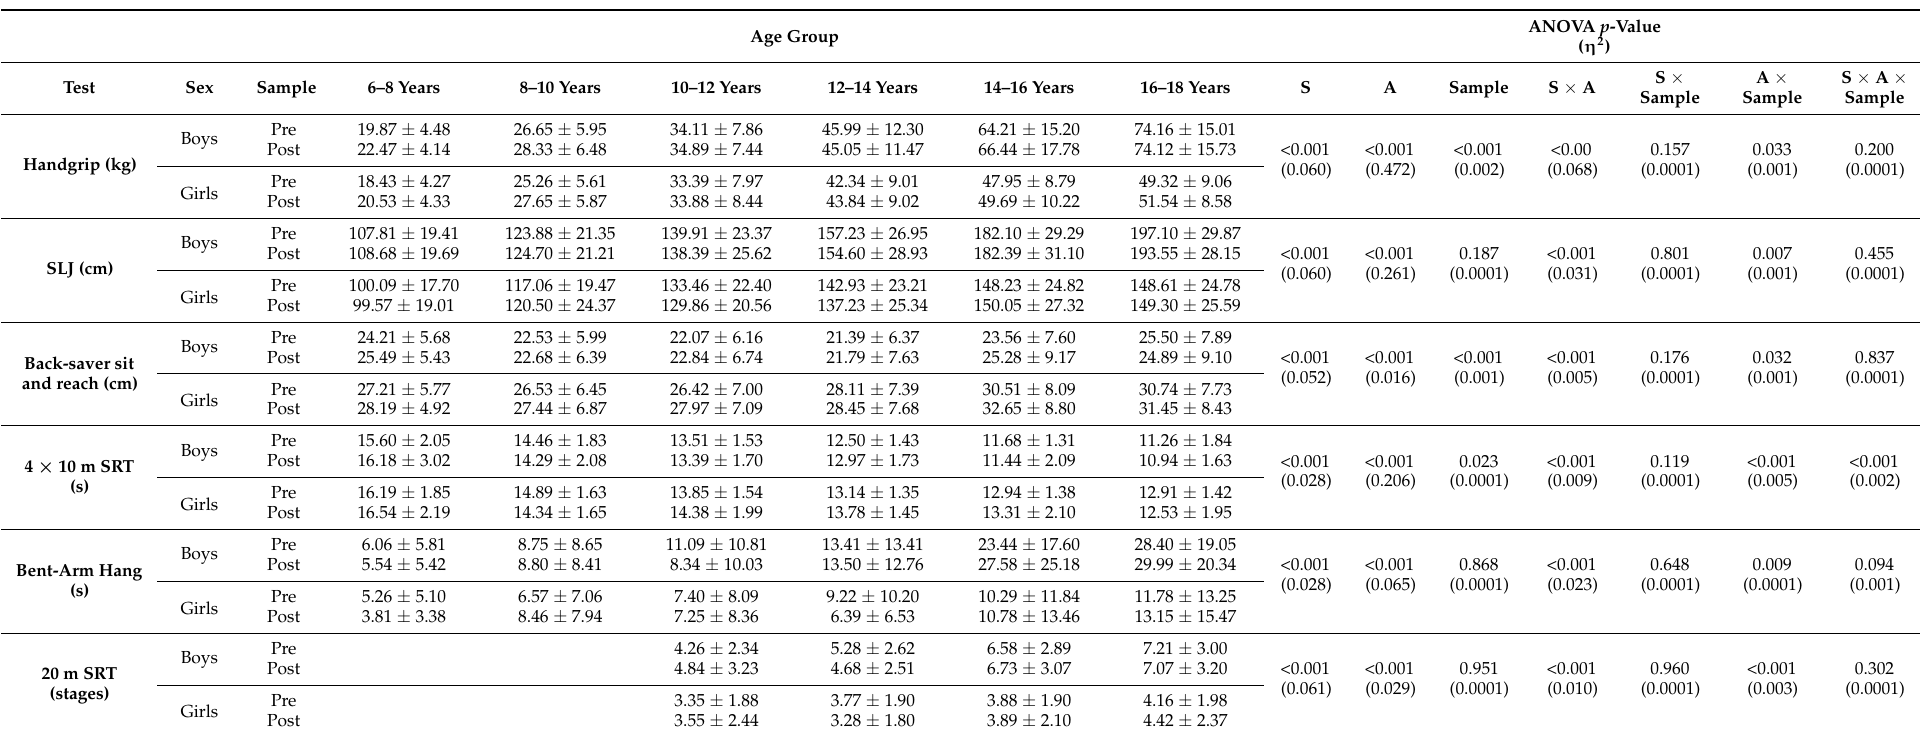
Table 2. Physical fitness values before and during